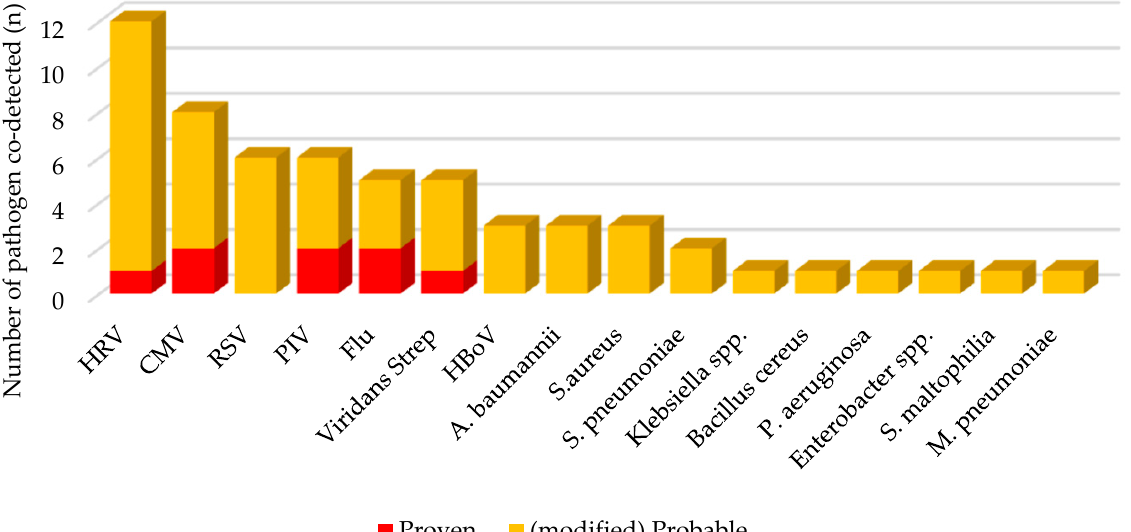
Figure 2. Frequency of respiratory pathogens co-detected in children with clinical PCP. PCP, Pneu- mocystis jirovecii pneumonia; n , number; HRV, human rhinovirus; CMV, cytomegalovirus; RSV, respiratory syncytial virus; PIV, parainfluenza virus; Flu, influenza virus; Strep, Streptococcus ; HBoV, human bocavirus; A. baumannii , Acinetobacter baumannii ; S. pneumoniae , Streptococcus pneumoniae. ; spp., species; P. aeruginosa, Pseudomonas aeruginosa; S. maltophilia, Stenotrophomonas maltophilia; M. pneumoniae, Mycoplasma pneumoniae